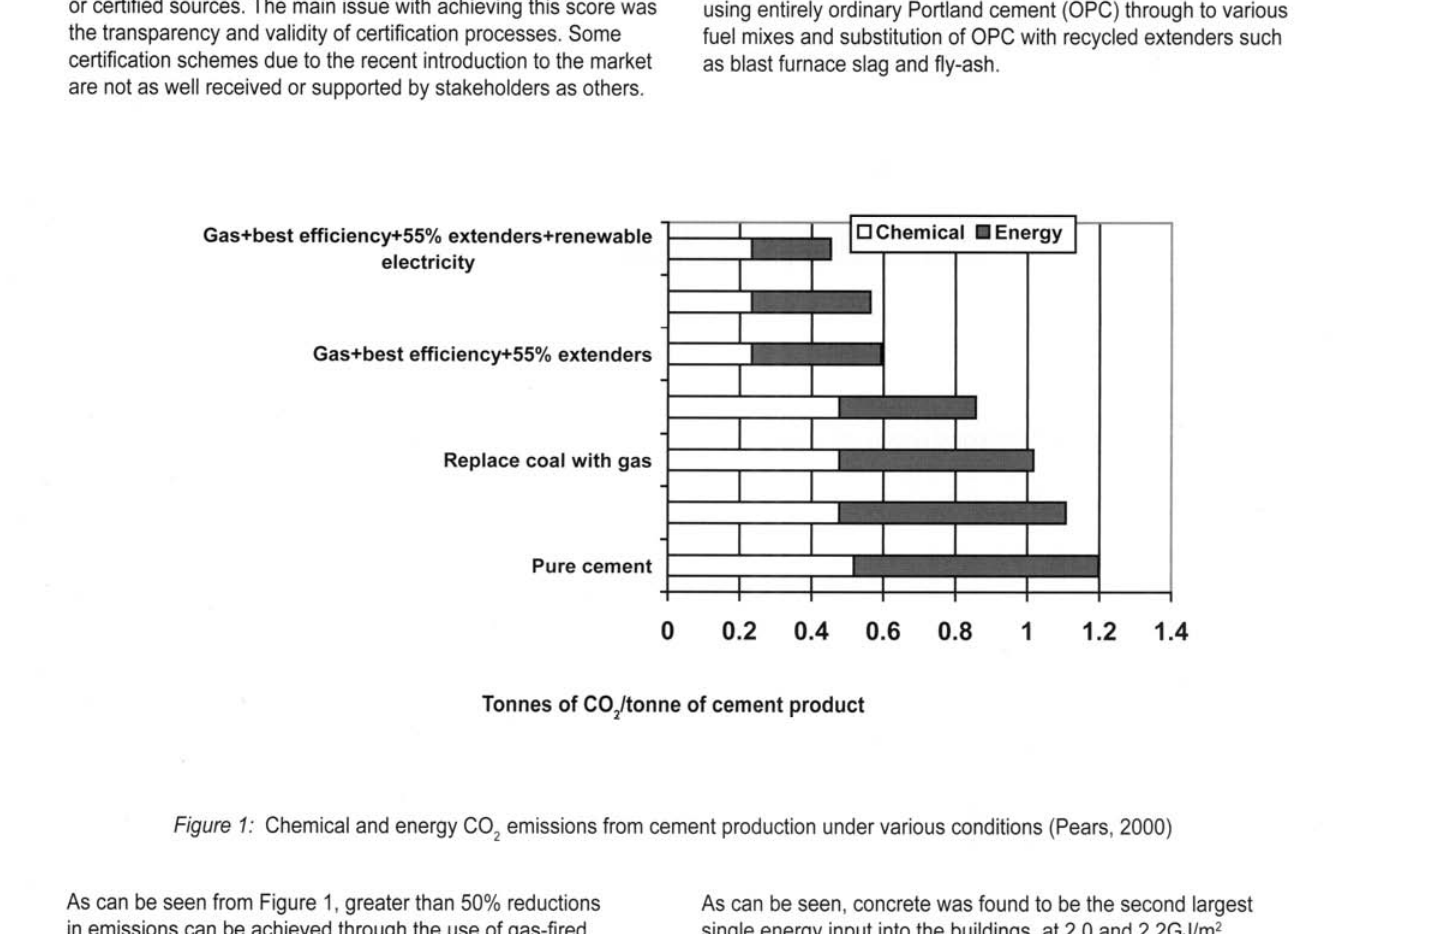
Figure 1: Chemical and energy CO2emissions from cement production under various conditions (Pears,